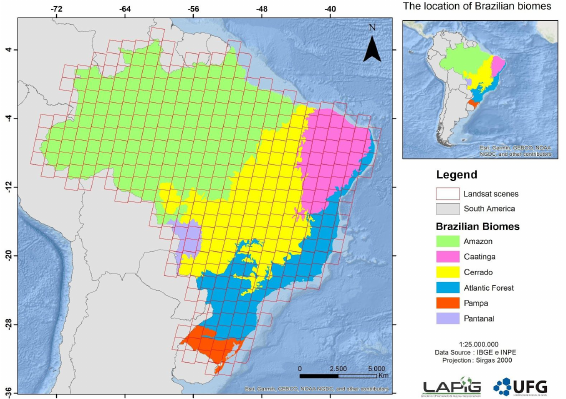
Figure 1. Image Chart of the location of Brazilian